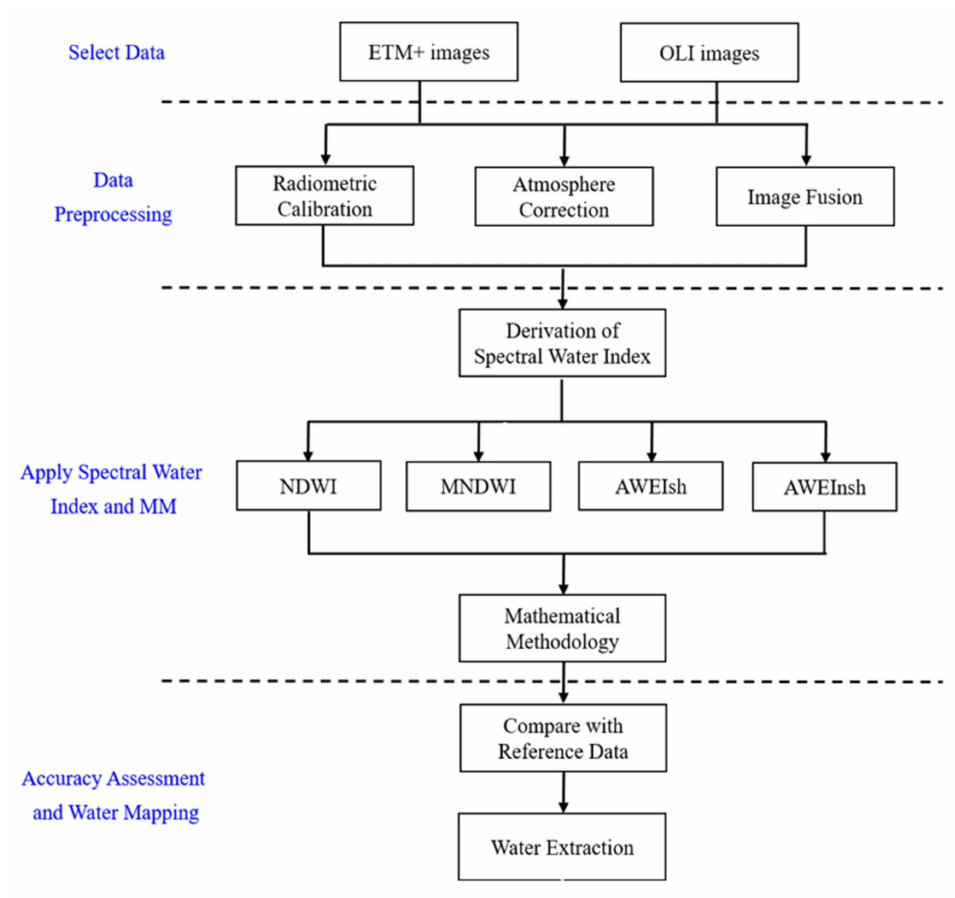
Figure 2. Research flow chart.